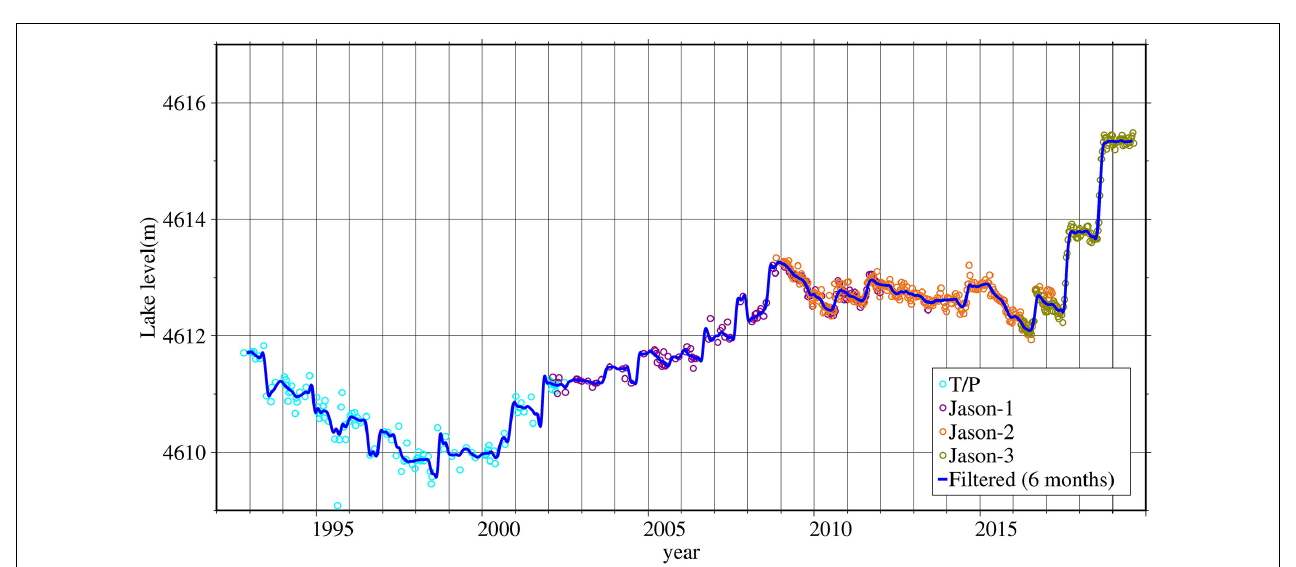
FIGURE 6 | Mean lake level derived from various satellites and histograms of their STDs. (A) Mean lake level; (B) TOPEX/Poseidon; (C) Jason-1; (D) Jason-2; (E) Jason-3; (F) The relationship between wind speed and STD.